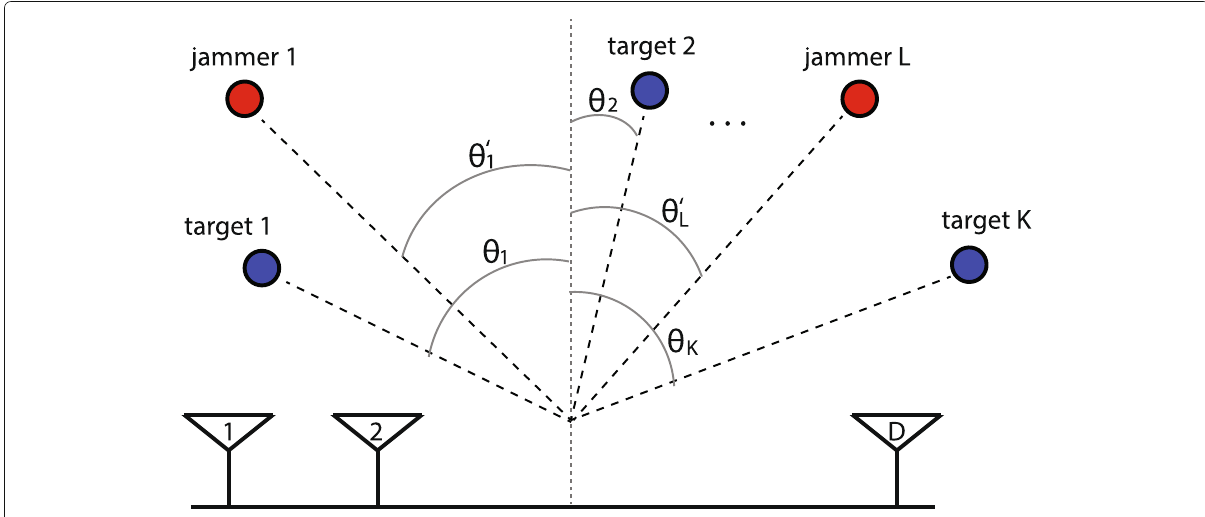
Fig. 1 Schematic representation of the K target sources and the L directional jammers